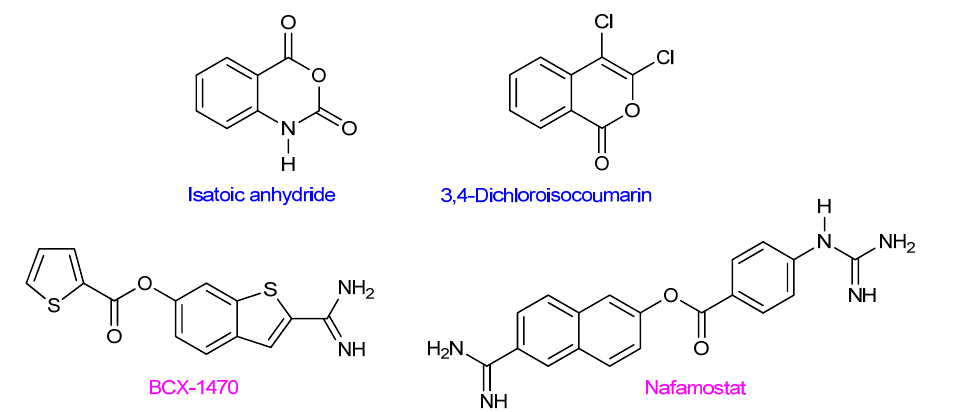
Figure 2. Structures of reversible and non-selective FD inhibitors. Isatoic anhydride, 3,4-Dichloroisocoumarin, and BCX-1470 were used primarily as molecular probes. Nafamostat has found some limited pharmacological use (IV administration) for patients with acute kidney injury and pancreatitis.